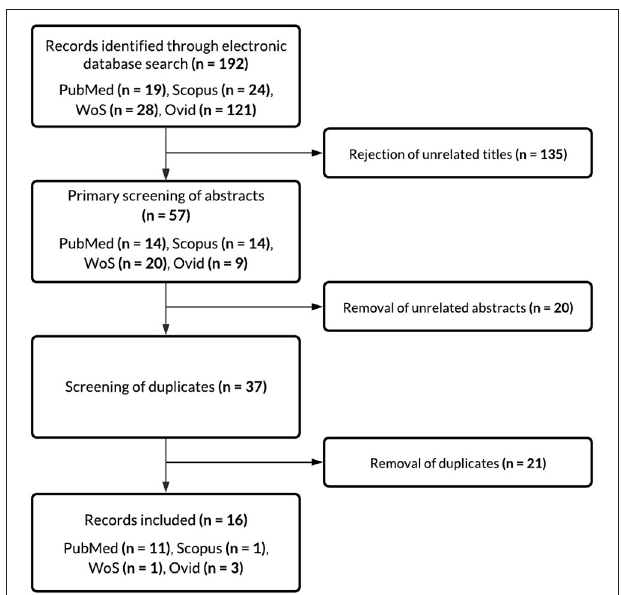
coated with various substances to improve re-endothelialization.